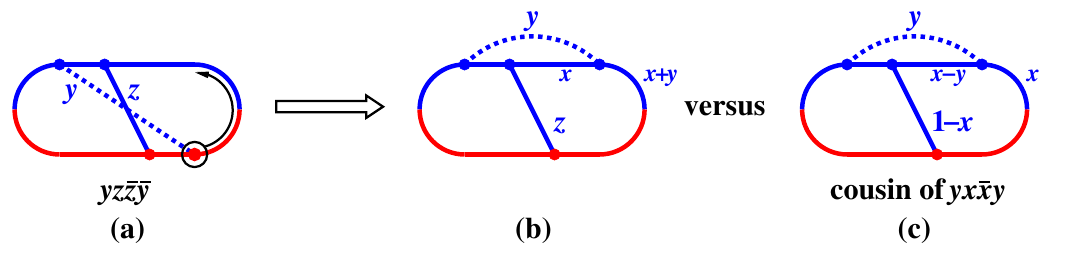
Figure 11 . (a–b) The back-end transformation of the x ↔ z permutation of yx ¯ x ¯ y compared to (c) the x → 1 − x cousin of the Class I virtual diagram yx ¯ xy